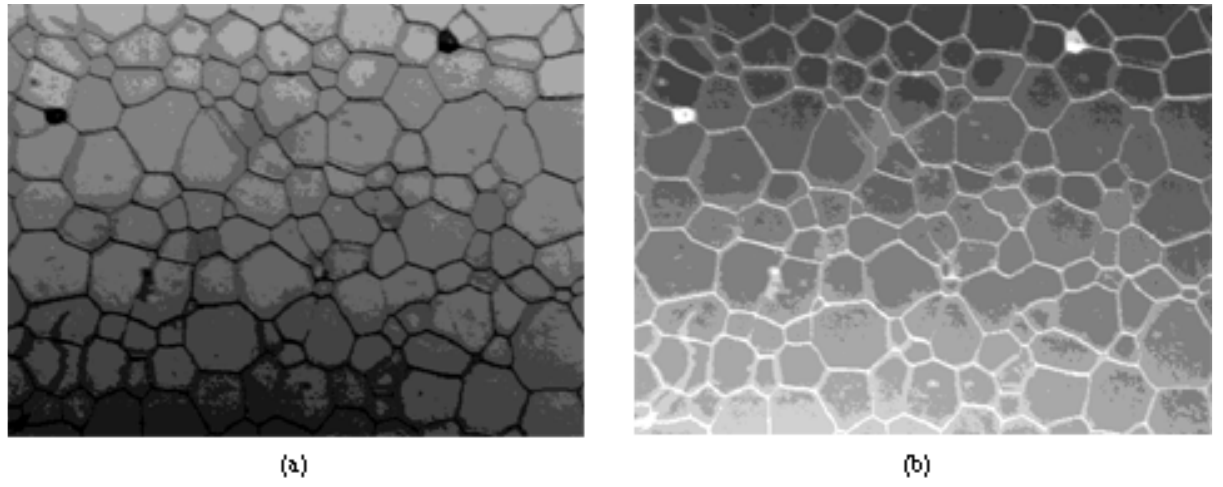
Figure 1. Micrograph of a highly magnified cross section of a uranium oxide sample: (a) original, and (b) negative image.